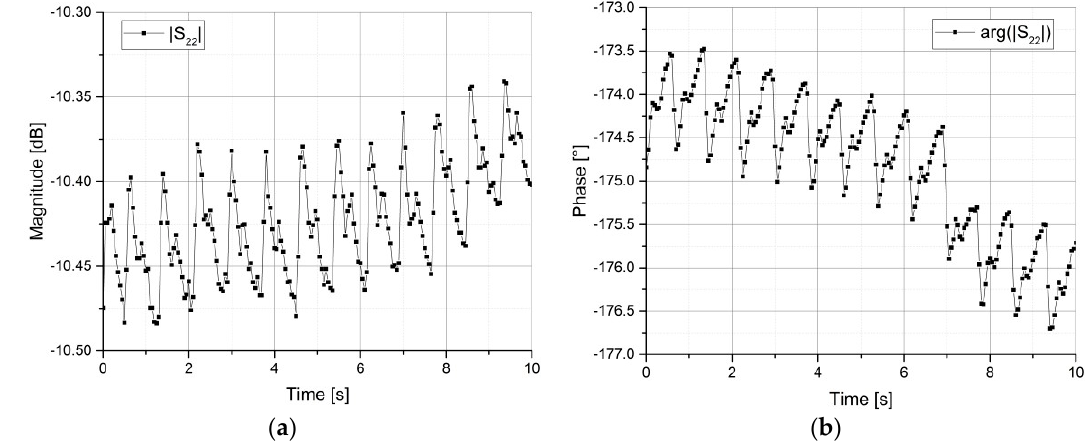
Figure 5. Network Analyzer measurements of the reflection coefficient S 22 of the symmetrical split- ring resonator over 10 s. ( a ) Magnitude in dB; ( b ) Phase in